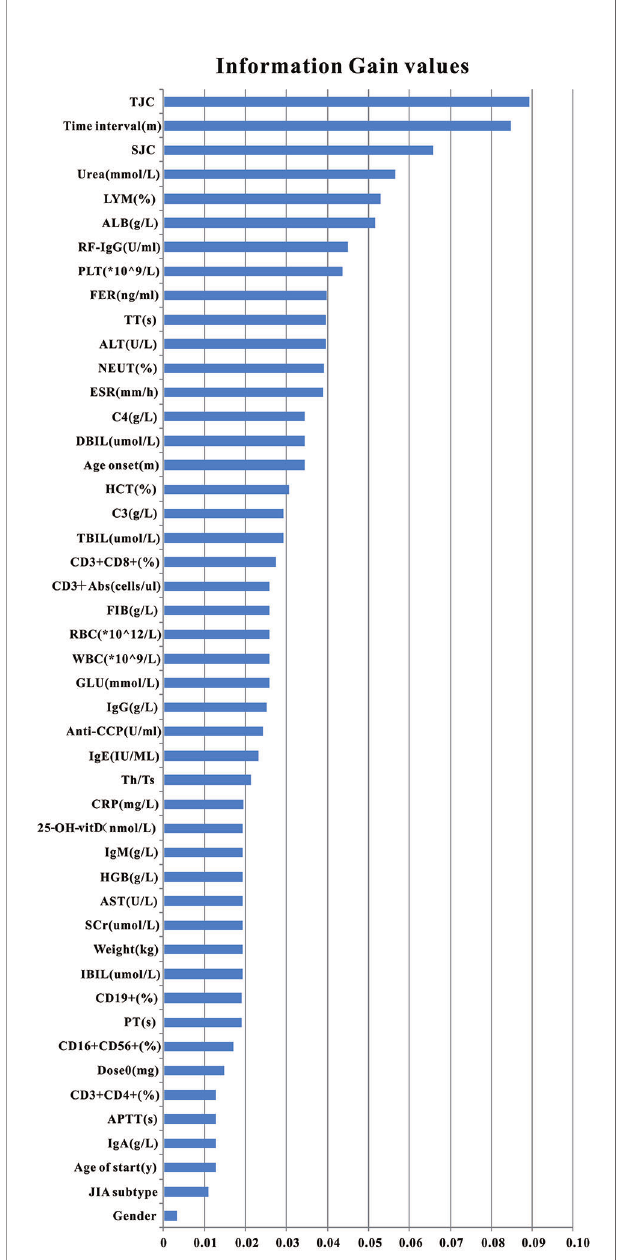
FIGURE 1 | Clinical variables used for model generation and their information gain values. Total 47 pre-administration clinical variables were used to generate models. Variables were ranked according to their information gain values which re fl ect the entropy gain with respect to the outcome. The longer the blue transverse column (the higher the value), the greater importance on the